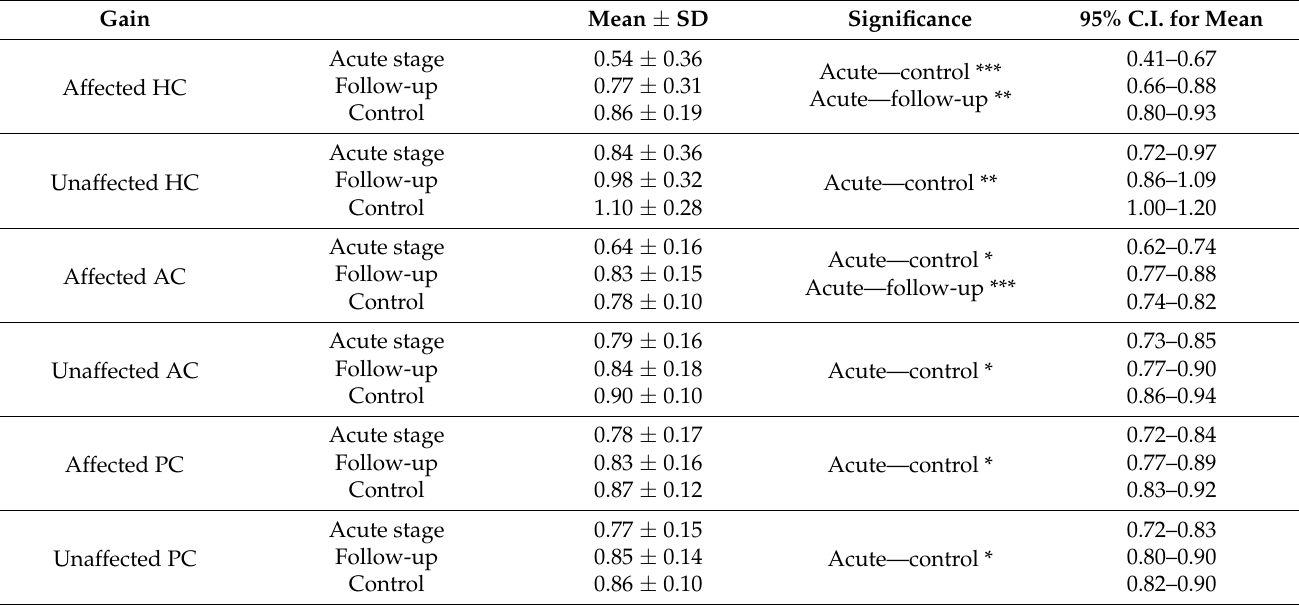
Table 1. Gain values of vHIT in vestibular neuritis at the acute stage and follow-up during head movements towards the affected and unaffected side, respectively, in horizontal (HC), posterior (PC) and anterior (AC) plane (see also Figure 1). *** p < 0.001, ** p < 0.01, * p < 0.05. SD: standard deviation, C.I.: confidence